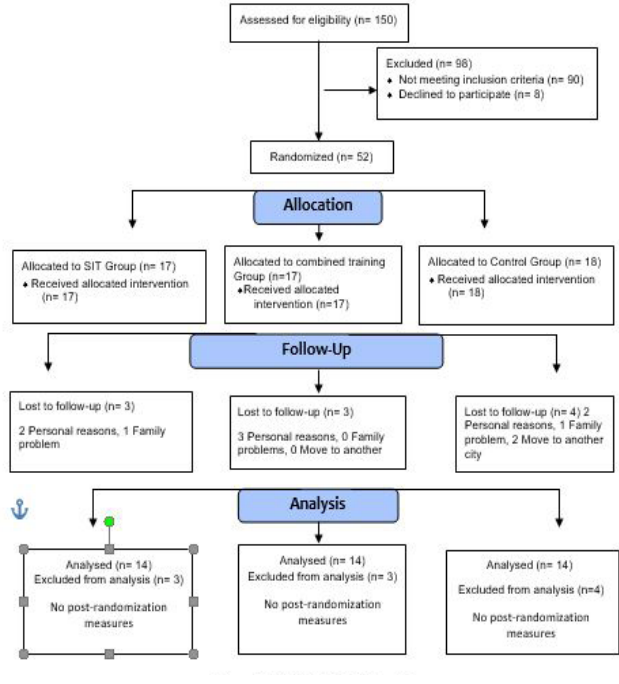
Figure 1. CONSORT 2010 Flow